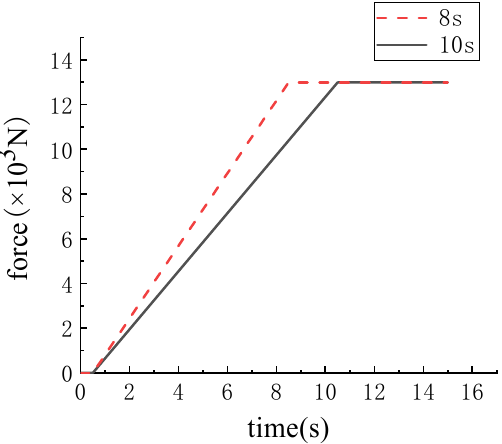
Figure 10. Conventional fi xed slope engagement pressure loading curve.